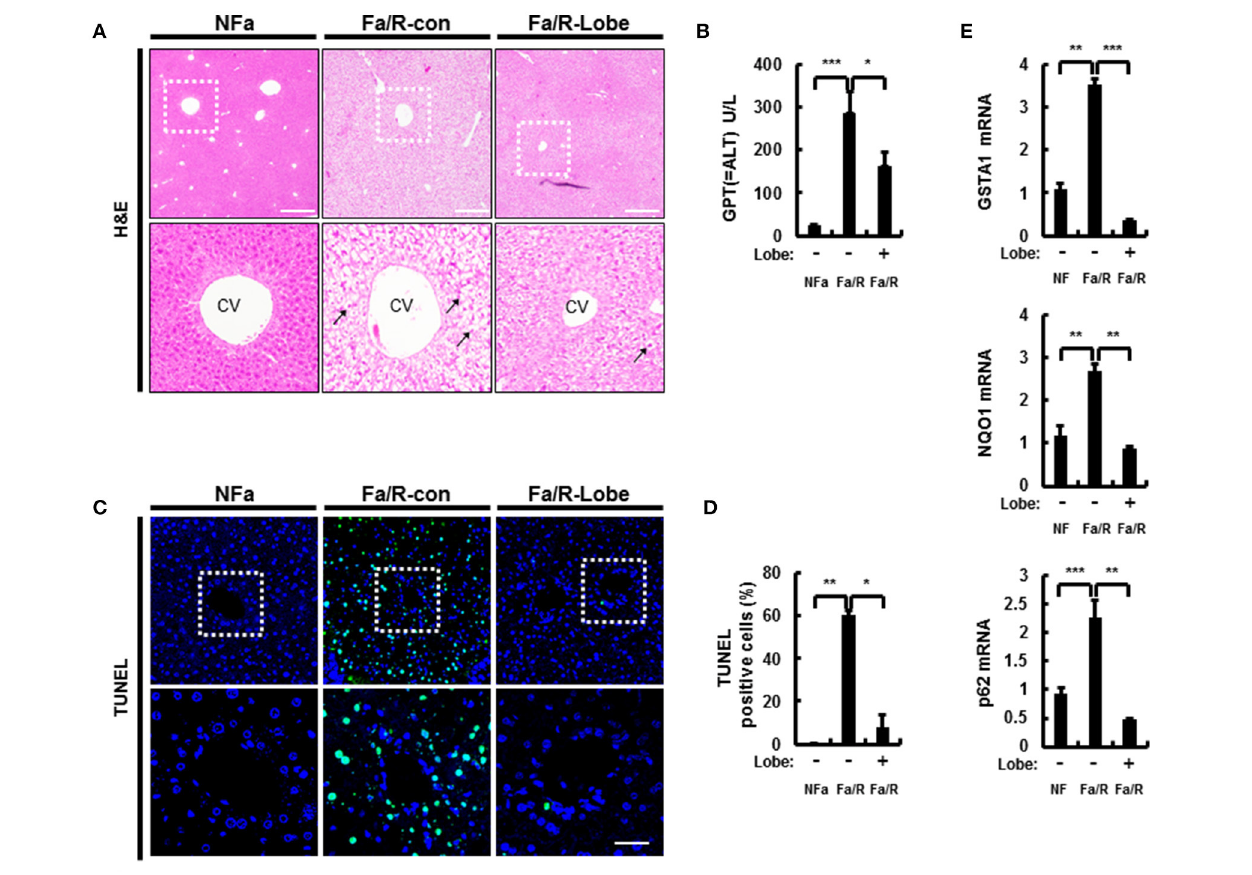
FIGURE 1 | Lobeglitazone ameliorates acute lipogenic stimulus-mediated liver injury in mice. (A–E) Mice were maintained in a non-fasted state (NFa) ( n = 8) or fasted overnight and then refed a high-carbohydrate, fat-free diet (Fa/R) with vehicle ( n = 9) or lobeglitazone ( n = 9). (A) The liver sections from mice were stained by using H&E. The extent of ballooning degeneration (arrow) is indicated on the bottom right set of images. CV, central vein. Scale bar = 200 µ m. (B) The serum alanine aminotransferase (ALT) concentration was measured in each group of mice. (C) Images for TUNEL analysis of liver sections from each three groups of mice. Scale bar = 100 µ m. (D) Quantitative graph of the TUNEL images of the liver sections. The data are the mean ± standard error for eight or nine mice of each group. * p < 0.05 and ** p < 0.01. (E) Total RNA isolated from liver was subjected to qRT-PCR analysis of GSTA1 (top), NQO1 (middle), and p62 (bottom) mRNAs. The data are presented relative to the corresponding value for non-fasted mice and are the mean ± standard error for eight or nine mice in each group. * p < 0.05, ** p < 0.01, and *** p <